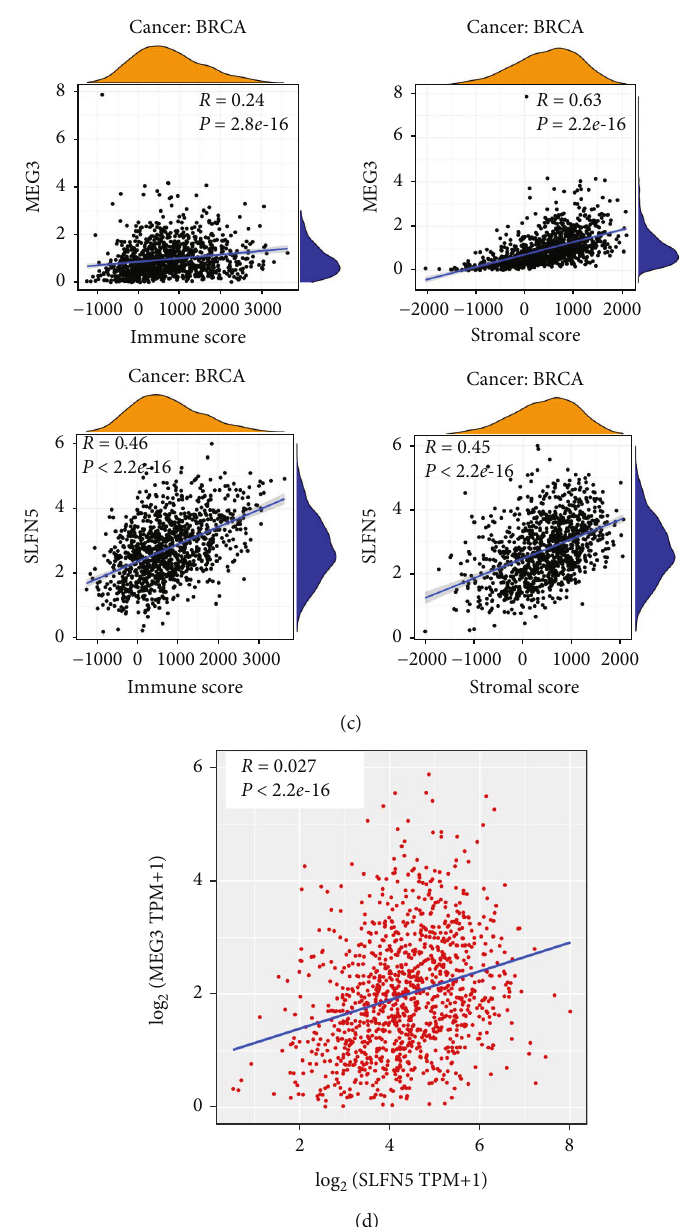
Figure 1: The MEG3 expressed in pan-cancers and the correlation with SLFN5 in BRCA based on TCGA database and UCSC Xena website. (a) Analysis of MEG3 expression in 33 types of tumor tissues compared with normal tissues, decreased in 24 types of tumor tissues (such as BRCA, LUAD, LUSC, and OV), increased in 4 types of tumor tissues (CHOL, DLBC, TGCT, and THYM), with no signi fi cant di ff erence in 3 types of tumors (HNSC, PCPG, and SARC), and no normal group information in the remaining 2 types of tumors (MESO and UVM). (b) Analysis of MEG3 expression in 1085 BRCA and 291 normal tissues. (c, d) The correlation analysis between TME (immune score and stromal score) and MEG3 or SLFN5 in BRCA. ∗ P < 0 : 05 , ∗∗ P < 0 : 01 , ∗∗∗ P < 0 : 0001 . Abbr. TCGA: The Cancer Genome Atlas; TME: tumor microenvironment. BRCA: breast